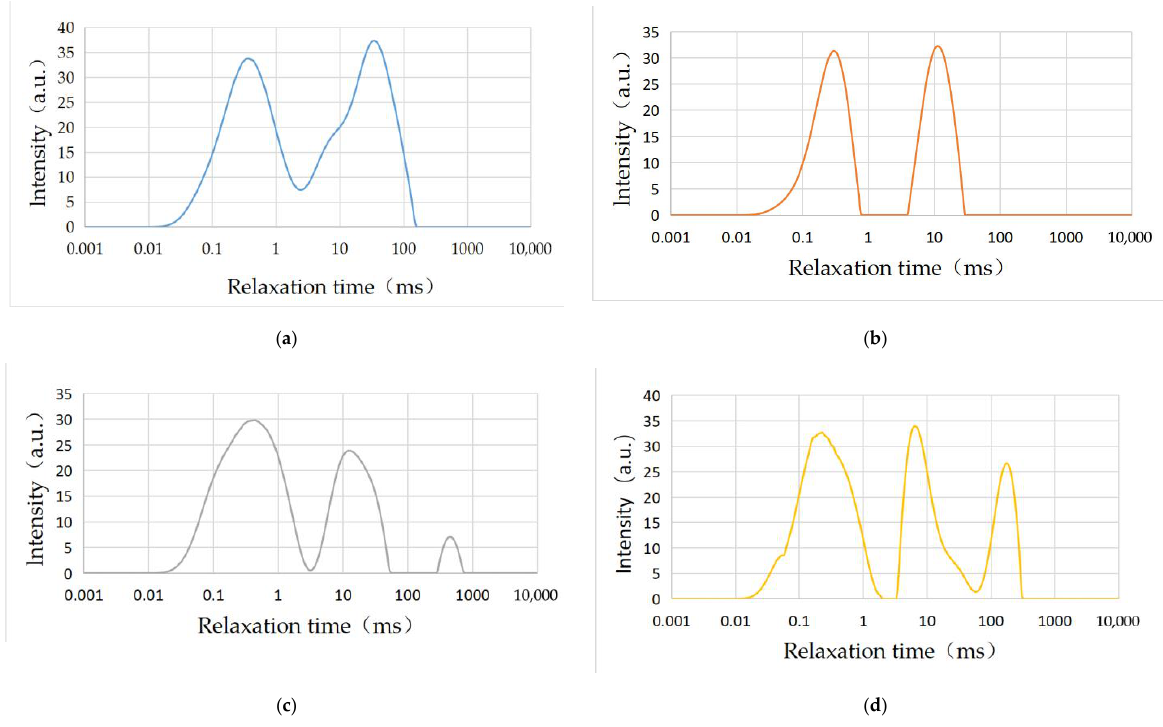
Figure 11. T 2 spectrum of carbonate samples after dissolution under different test conditions: ( a ) sample 5#; ( b ) sample 6#; ( c ) sample 7#; ( d ) sample 8#.